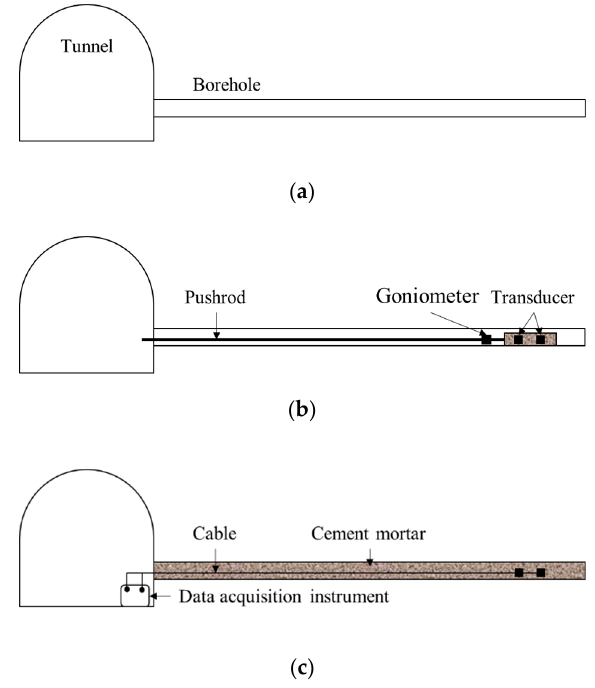
Figure 5. Testing procedures of the RSR method. ( a ) Hole drilling; ( b ) transducer installation; ( c ) hole grouting and data